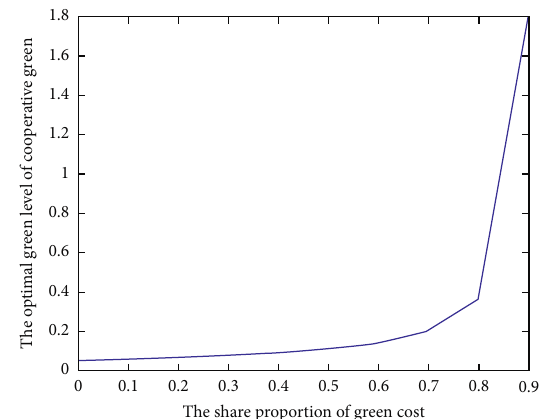
Figure 3: The relationship between the supplier’s optimal green input level and the cost coefficient.